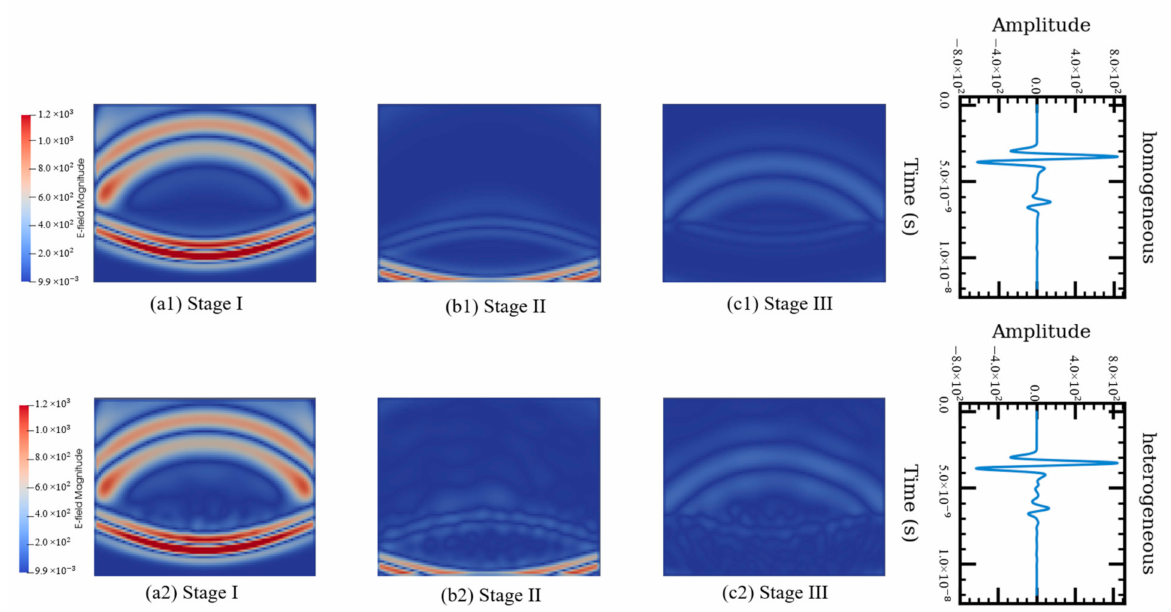
Figure 6. Comparison between the one- and three-phase AC simulation